Question: What visual encoding does this figure use to show its data?
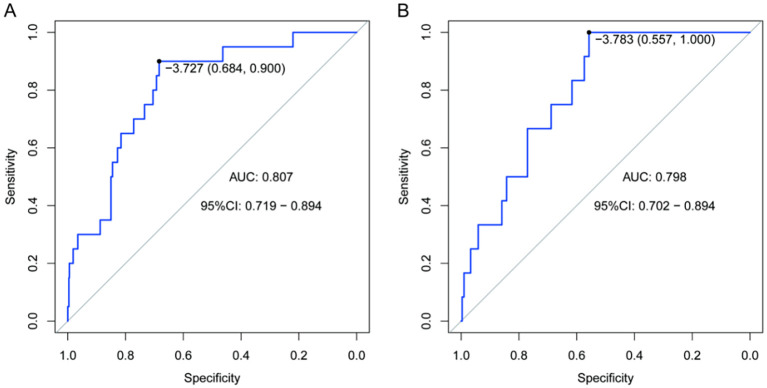
Answer: line